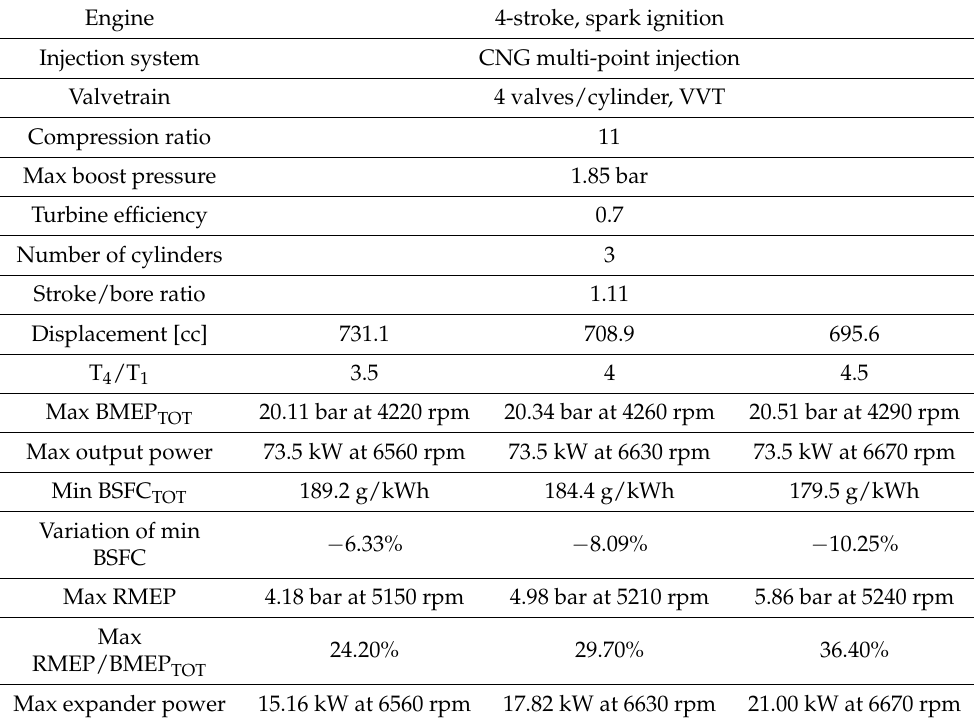
Table 7. Main characteristic of the compound engine obtained with η T = 0.7.